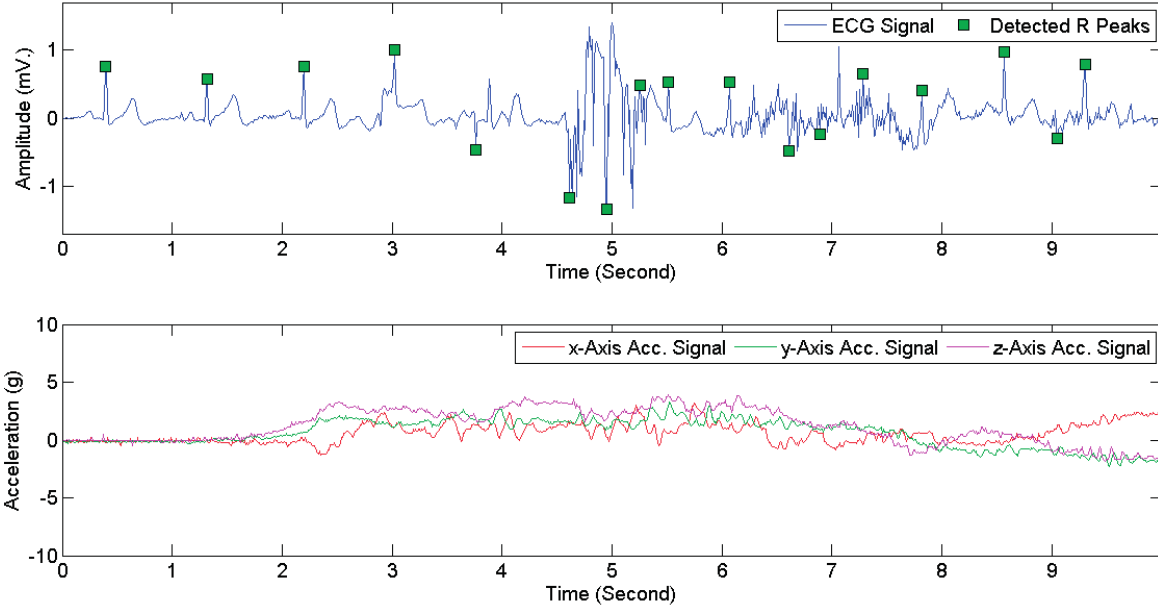
Figure 8. ECG signals ( Above ) and 3D acceleration signals ( Below ) when a subject made a transition from lying to